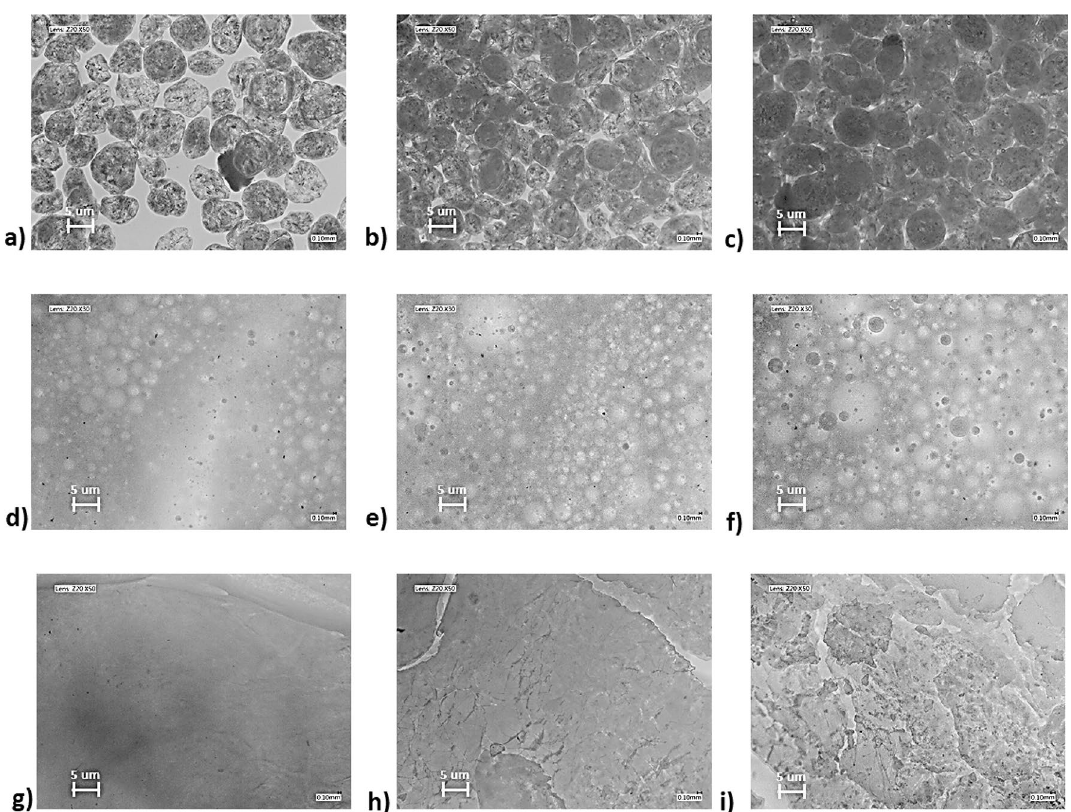
Figure 3. OLM imaging of the nNAMeGs manufacturing process: ( a–c ) BA mixing with PDMS precursor; ( d–f ) Homogenization of BA into PDMS; ( g–i ) final NNAMeG samples. Different stoichiometric Boron st X st X st ratios: ( a,d,g ) X BA = 0.2 (NNAMeG02); ( b,e,h ) BA = 0.5 (NNAMeG05); ( c,f,i ) BA = 0.8 (NNAMeG02).